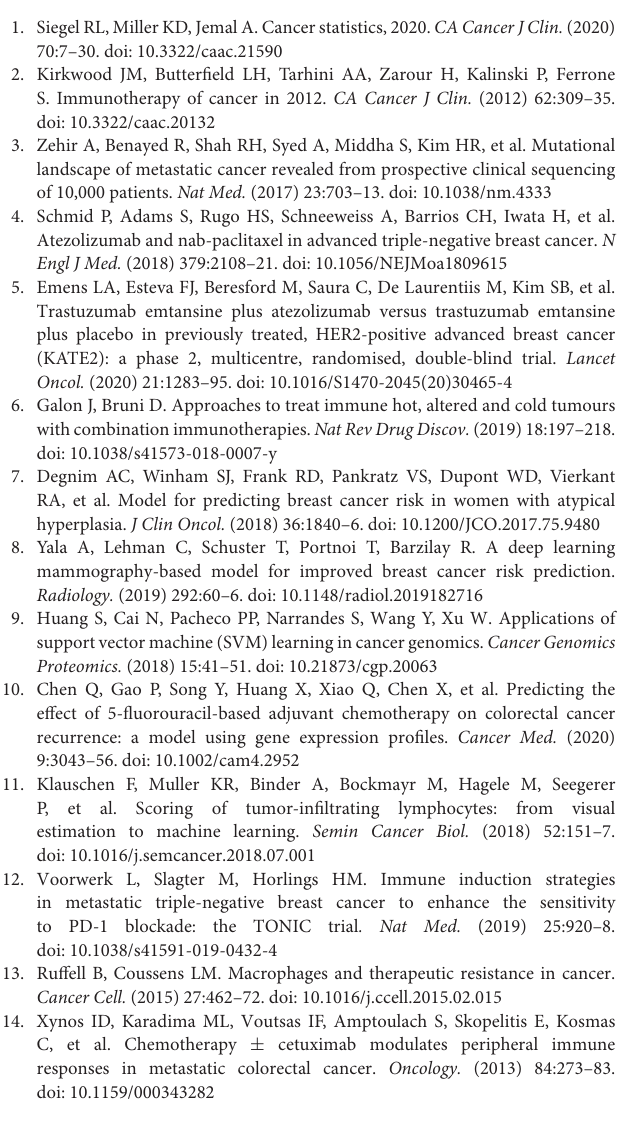
Supplementary Figure 1 | Spearman correlation between the peripheral immune indexes before neoadjuvant chemotherapy. Supplementary Figure 2 | Spearman correlation between the peripheral immune indexes after neoadjuvant chemotherapy. Supplementary Figure 3 | Evaluation of single immune index. (A) ROC and AUC of single immune index; (B) KM plot of CD16 + CD56 + NK cell